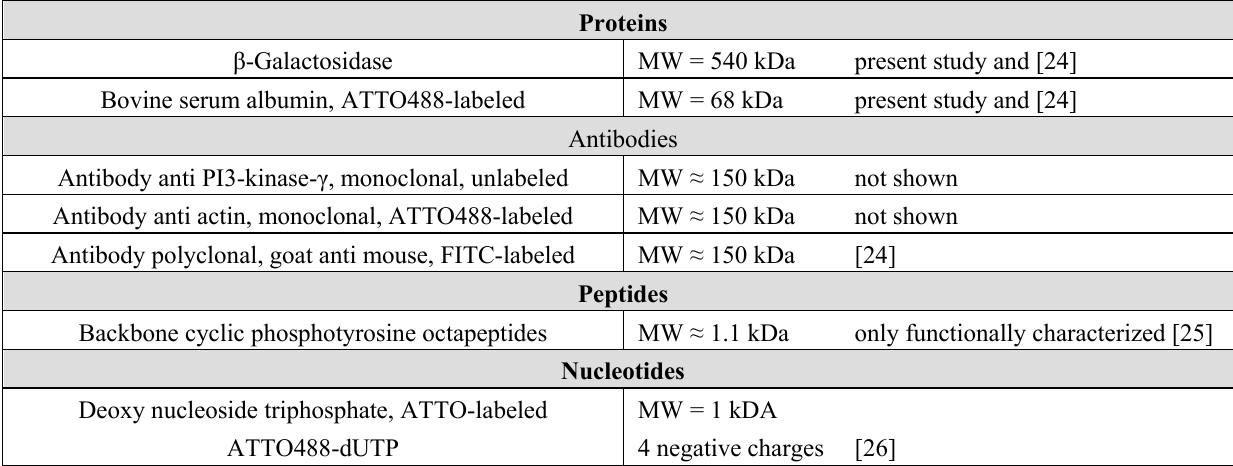
Table 2. Cargoes used in different studies.